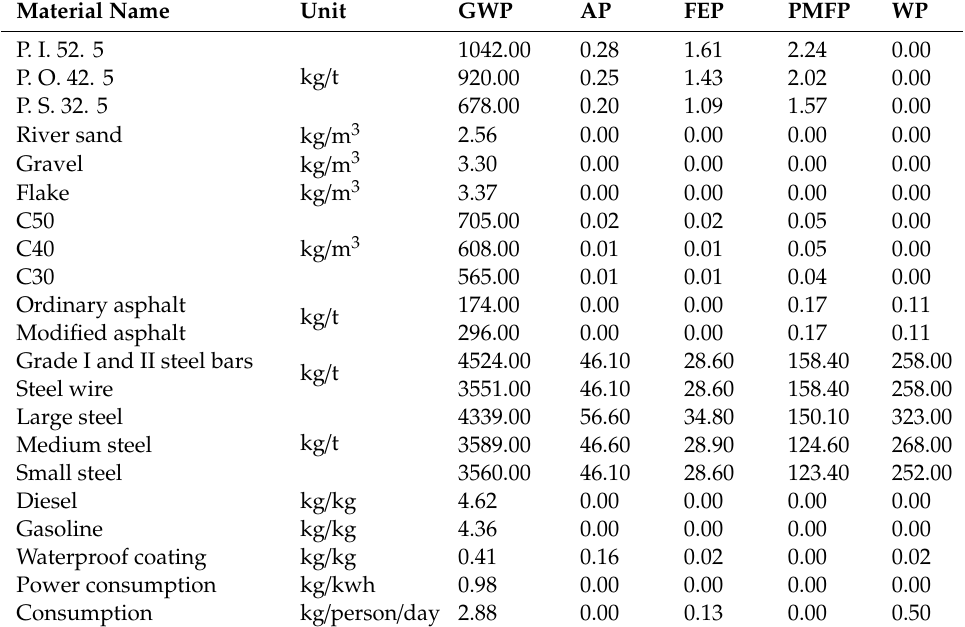
Table 1. Environmental impact contribution coe ffi cient of materials during the processing and construction